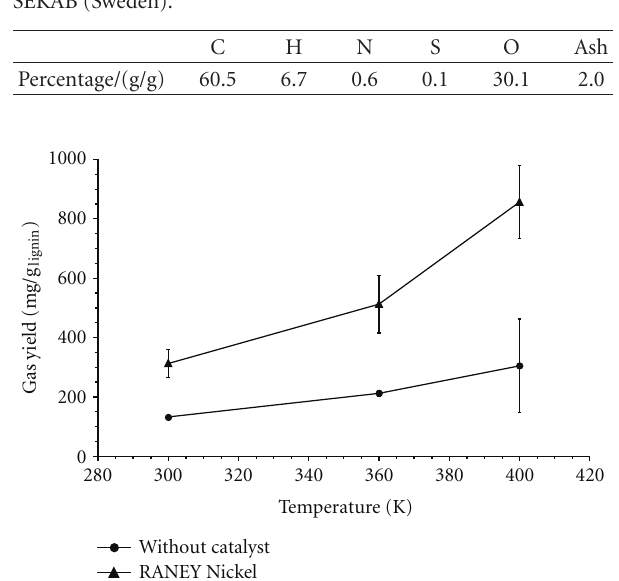
Figure 5: Yield of main products from hydrogenation of 10 g/L catechol in water with RANEY Nickel and H 2